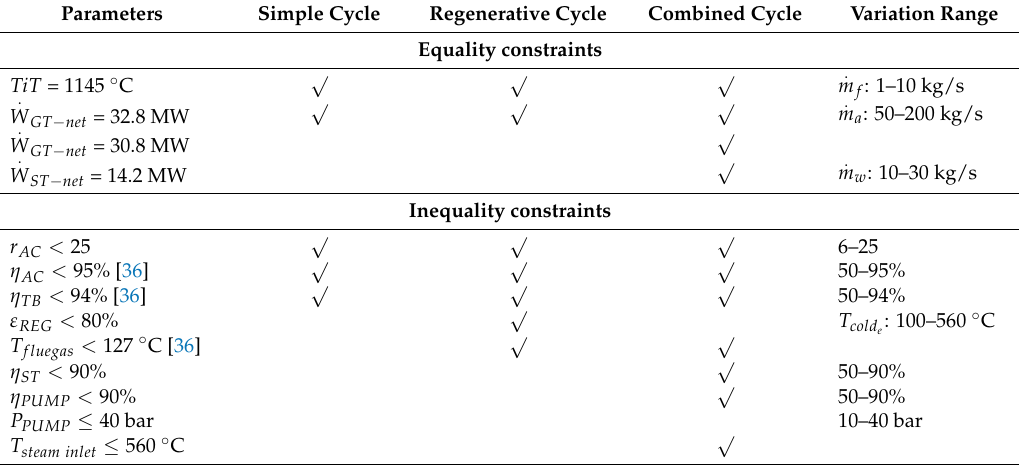
Table 5. Constraints and range of decision variables in mathematical